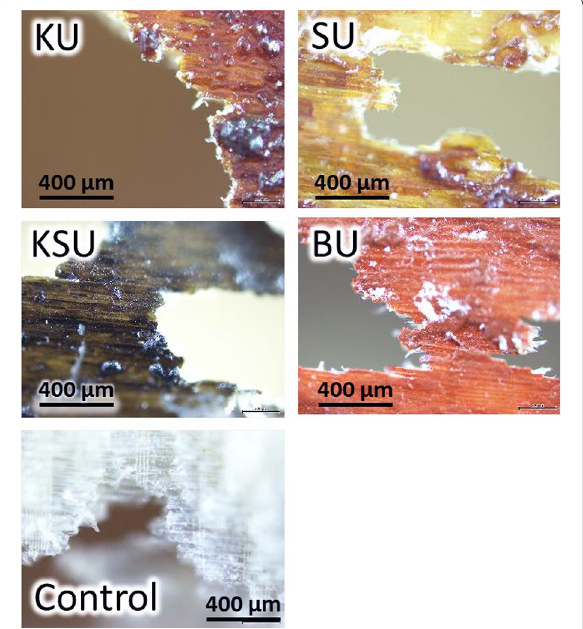
Fig. 3 The microscopic observation of sample surface after termite feeding test